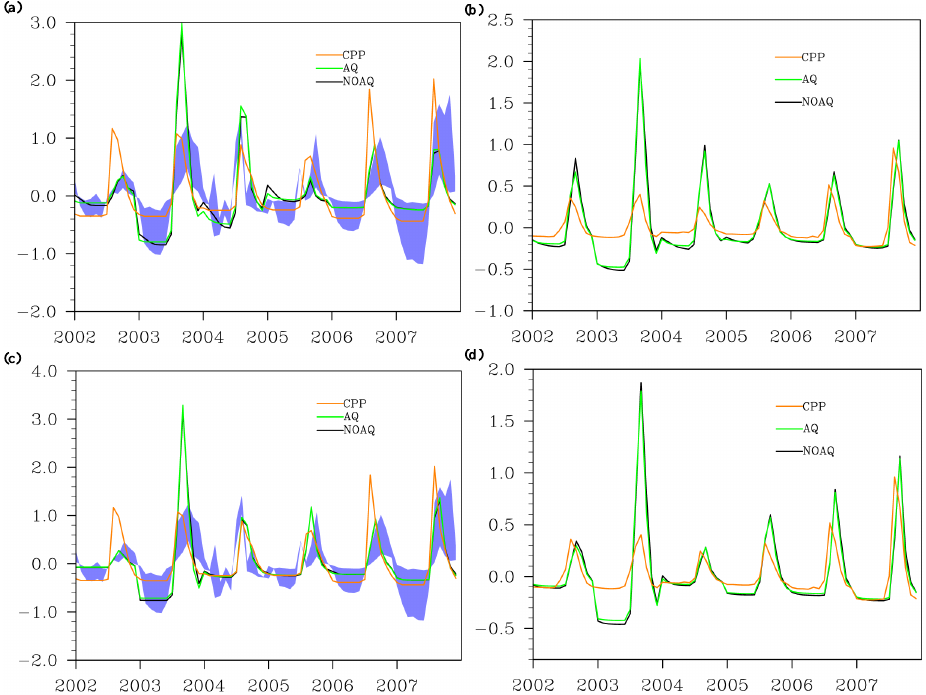
Fig. 8. (a) and (c) Time series of deseasonalized flood fraction anomalies (obtained by subtracting the 6-yr mean monthly value from individual months and then dividing by the standard deviation) over the delta. The blue range on the left figure delineates the maximum and minimum possible anomalies from Modis (JFC) products. The CPP product is orange. ISBA-TRIP without aquifers is in black and ISBA-TRIP with aquifers is in green. The TRMM-3B42 is used as forcing for (a) and RFEH is used for (c) . (b) and (d) Time series of deseasonalized flood fraction anomalies (obtained by subtracting the 6-yr mean monthly value from individual months and then dividing by the standard deviation) over the basin. The CPP product is orange. ISBA-TRIP without aquifers is in black and ISBA-TRIP with aquifers is in green. The TRMM-3B42 is used as forcing for (b) and RFEH is used for (d)